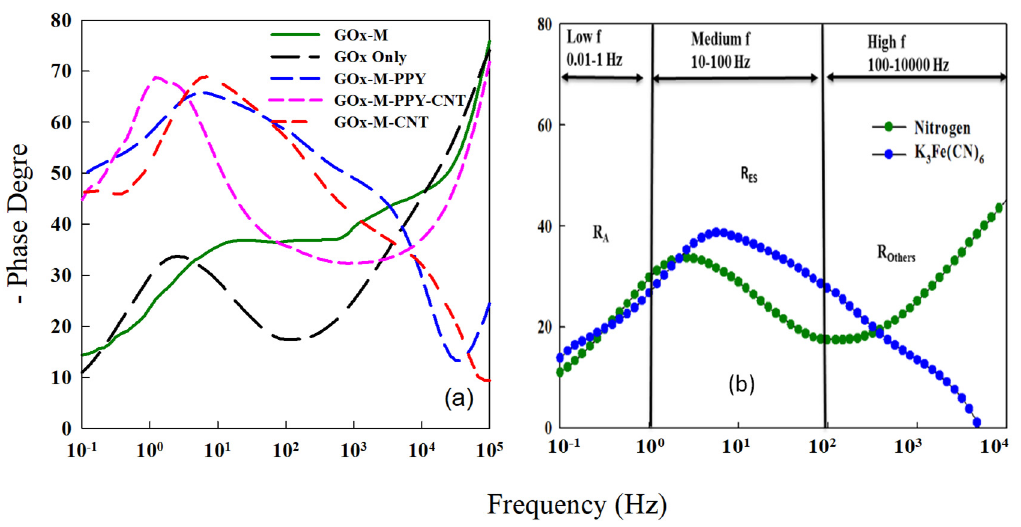
Figure 9. Bode phase angle plot of ( a ) GOx enzyme with different combinations of mediators, ( b ) the bioanode for potassium ferrocyanide and nitrogen.